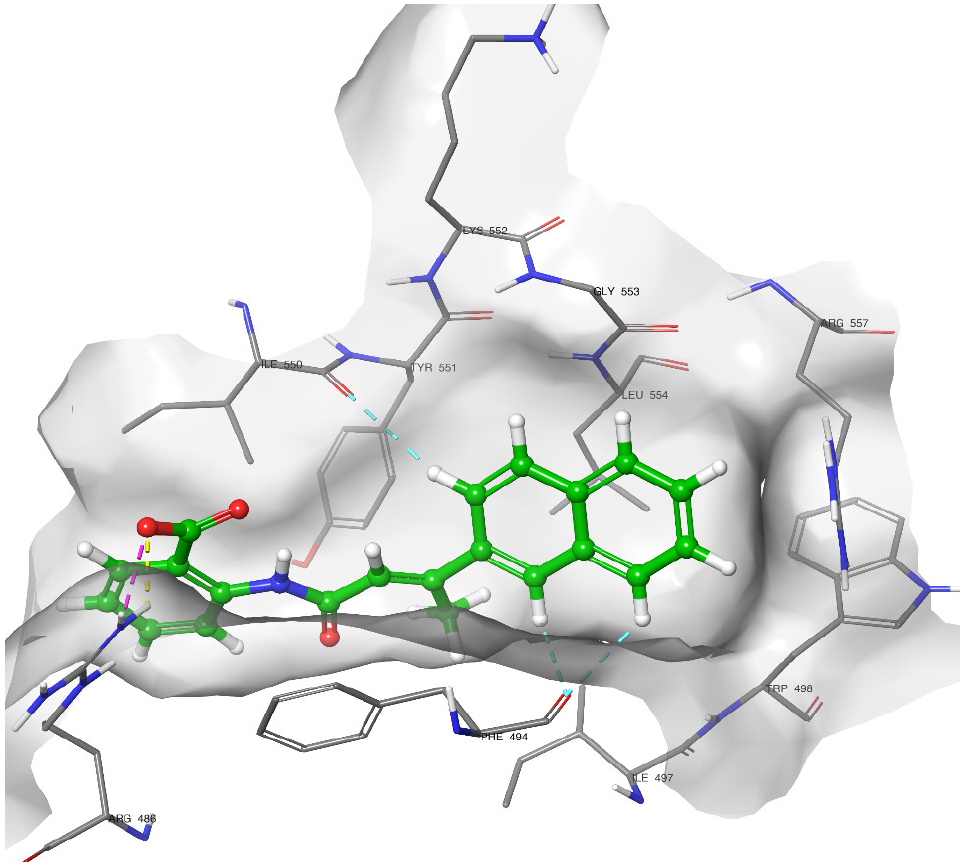
Figure 2. Binding mode after re-docking of BIBR1532: the yellow, dashed lines represent the H-bond interaction and, the purple, dashed lines represent the salt bridge between the O of the carboxyl group and Arg486, and the light blue dashed lines represent the aromatic H-bond interactions between the naphthyl ring and Phe494 and Ile550.